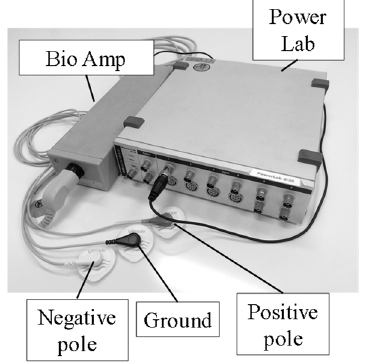
Figure 2. Electrocardiogram-based measurement.